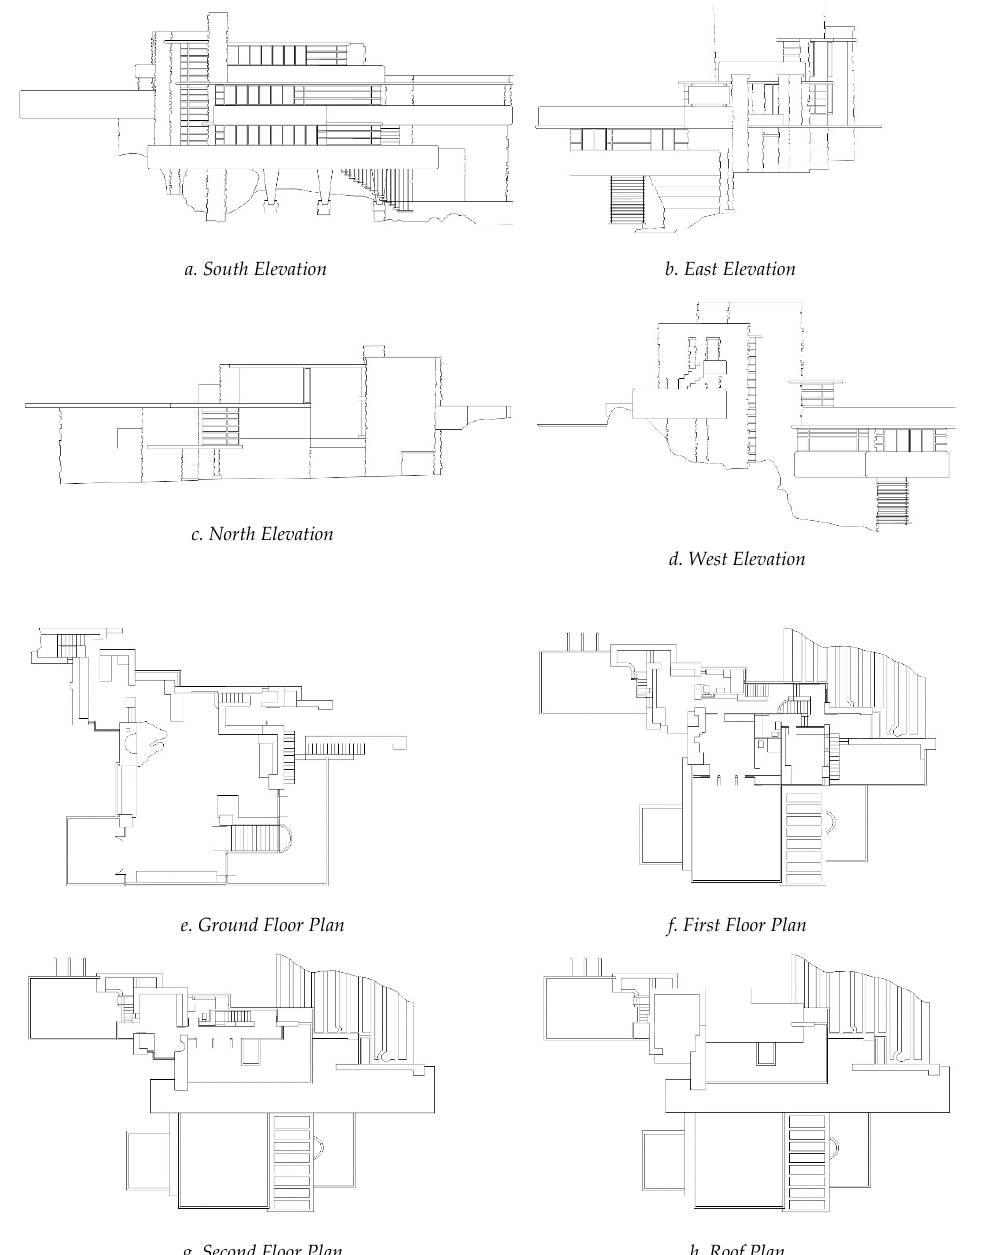
Figure 5. Elevations ( a – d ) and plans ( e – h ) of Fallingwater analyzed in this paper—not shown at a uniform scale. Table 3. Fallingwater